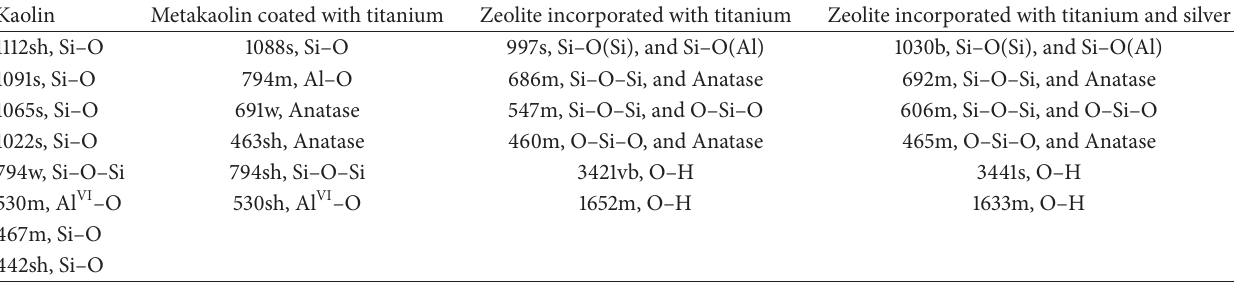
Table 1: Infrared bands (cm − 1 ) for Ti-K, Ti-MK, Ti-Zeolite Na-A, and Ti-Zeolite Ag-A. Kaolin